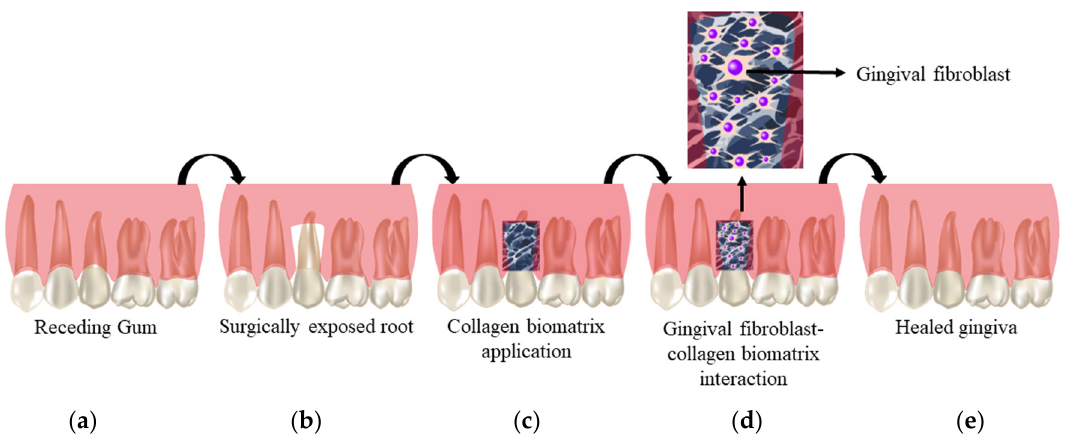
Figure 2. Cell biomaterial interaction: ( a ) receding gum; ( b ) exposed region of the gum; ( c ) collagen scaffold application; ( d ) mechanism of action of collagen biomatrix; ( e ) healed gingiva.